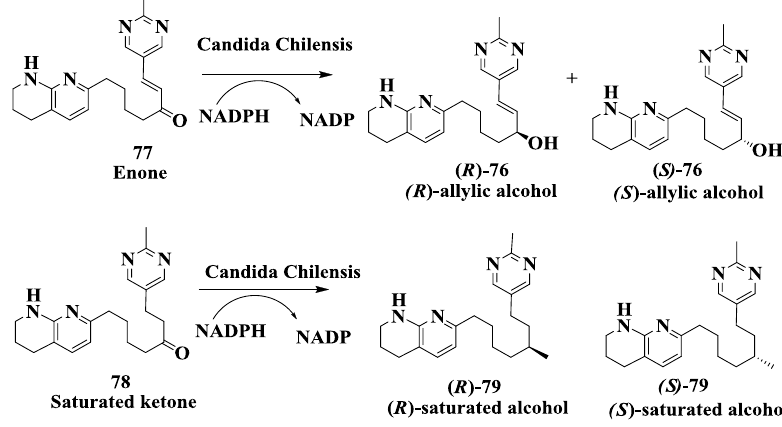
Figure 19. Integrin receptor agonist: Enzymatic preparation of ( R )-allylic alcohol.